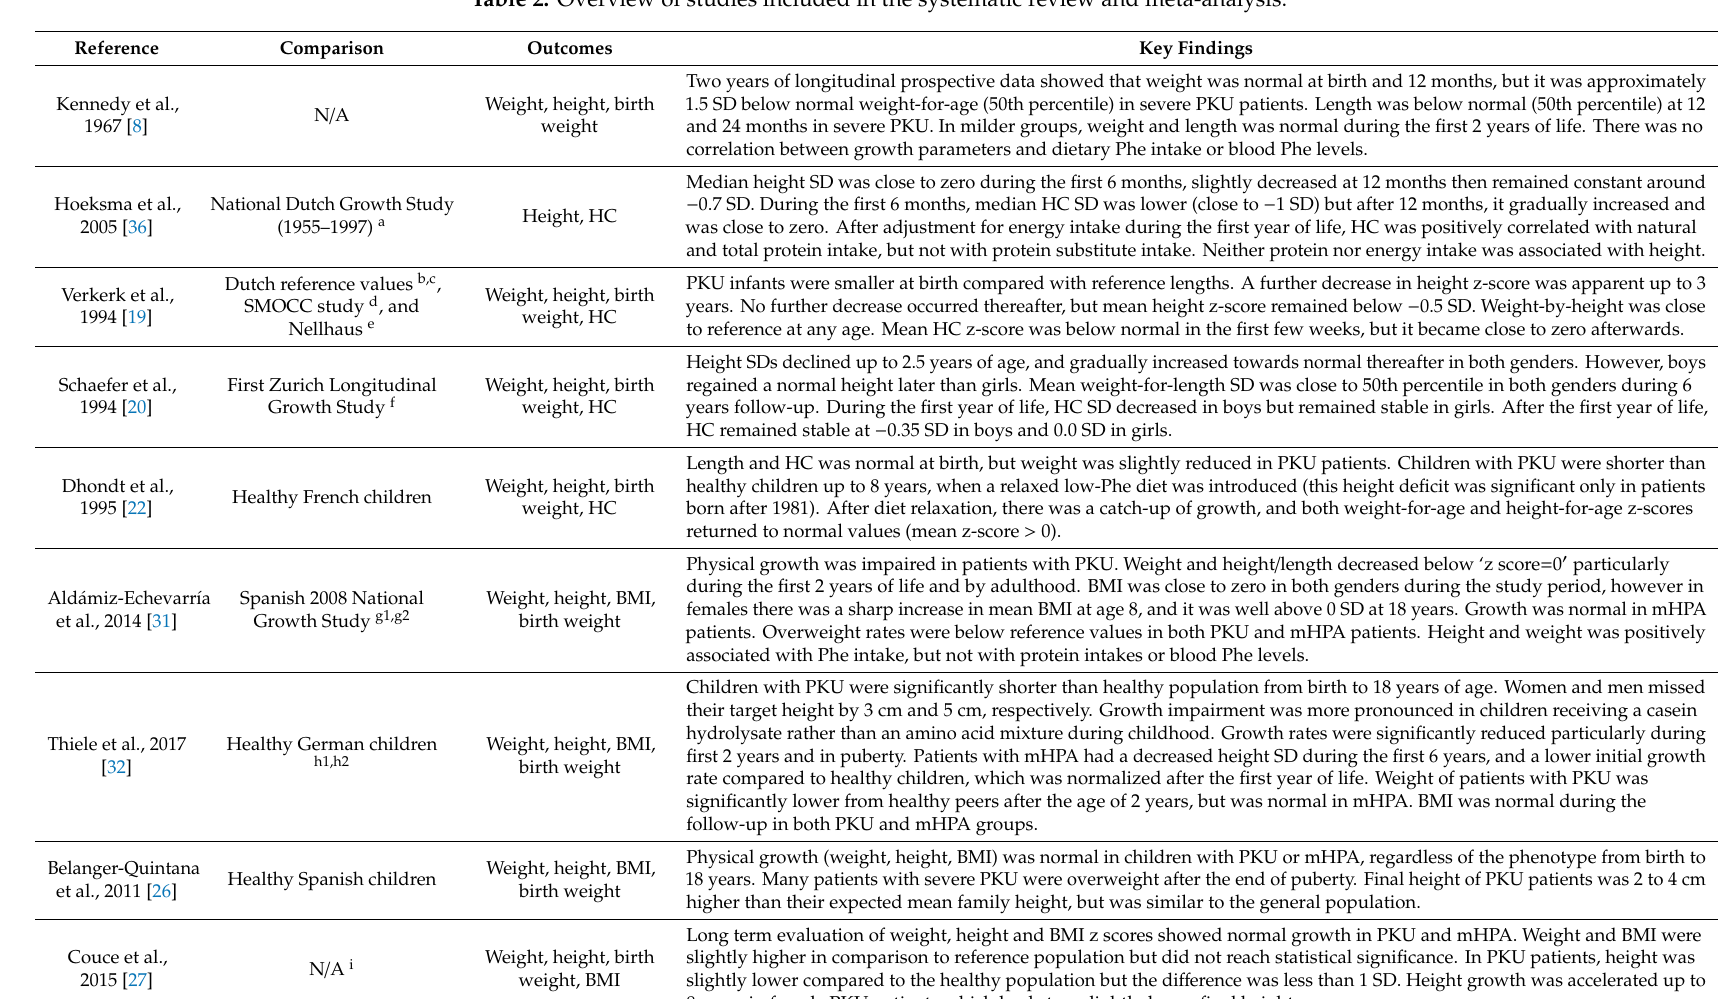
Table 2. Overview of studies included in the systematic review and